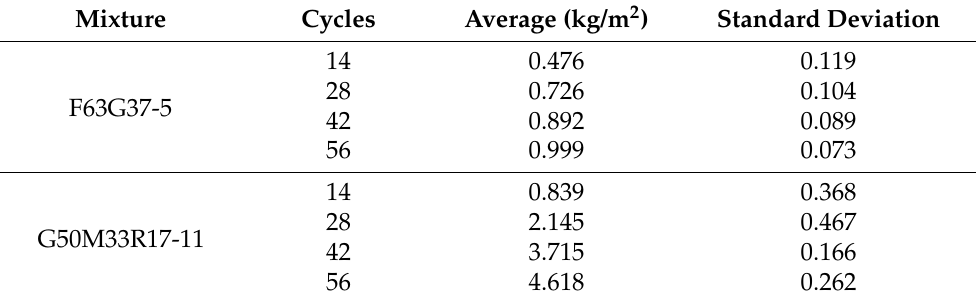
Table 5. Freeze-thaw resistance.